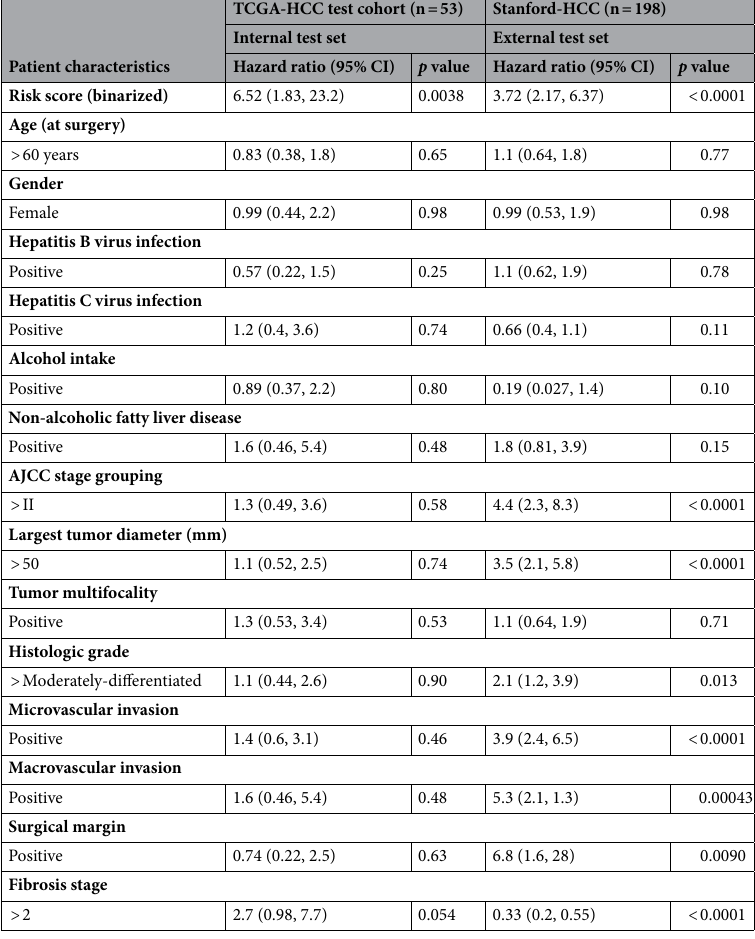
Table 2. Univariable Cox proportional hazards analysis of the risk of recurrence. CI, confidence